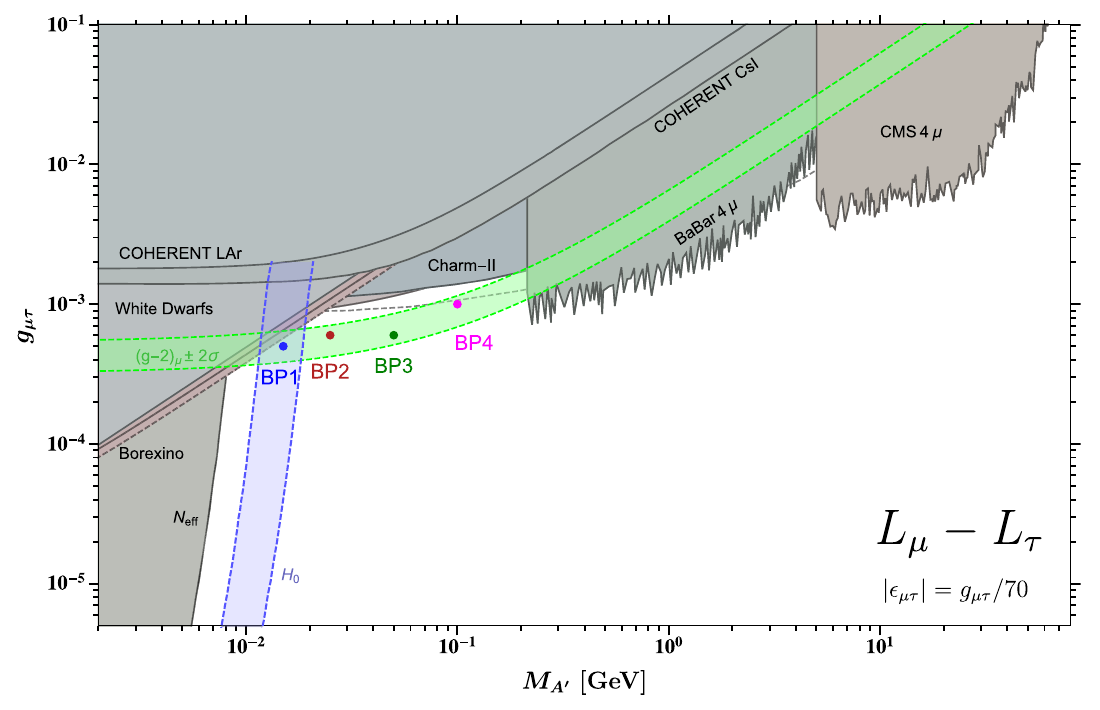
Fig. 1 Current constraints on the parameter space of the gauge boson of a minimal U ( 1 ) L μ − L τ gauge group from N eff [38], Borexino [56], white dwarf cooling [63], COHERENT CsI [55] and LAr [56], neu- trino tridents (Charm-II) [64,65] and BaBar [66] and CMS [67] 4 μ searches in grey. We show the neutrino trident constraint from CCFR as a grey dashed line, since some backgrounds have not been prop- erly taken into account [51]. The corresponding plot for a simplified U ( 1 ) L μ with the same kinetic mixing looks exactly the same with the